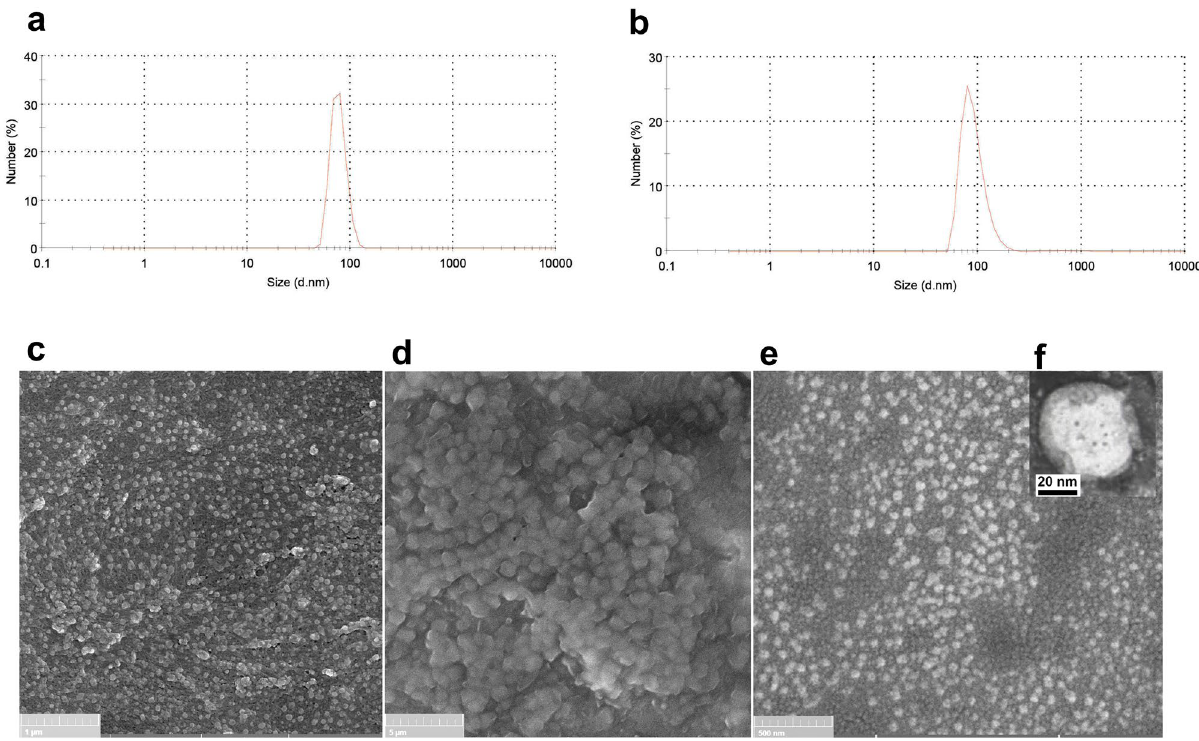
Figure 3. ( a ) DLS graphs of chitosan nanoparticles, ( b ) DLS graphs of chitosan-alginate nanoparticles, ( c ) FE-SEM image of chitosan nanoparticle, ( d ) SEM image of chitosan-alginate microparticles; ( e ) FE-SEM image of chitosan-alginate microparticles; and ( f ) TEM image of the chitosan-alginate 1419 cm −1 , and 1056 cm −1 , which corresponded to NH and OH stretching, stretching of the methyl group (– CH 3 ), C=O stretch of the amide group, aromatic C–H 2 bending, and C–O stretching, respectively. For TPP, the major peaks were detected at 1151 cm −1 , 905 cm −1 , and 710 cm −1 , corresponding to P=O stretch- ing, PO 3 group vibration, and P–O–P bridge asymmetric stretching, respectively. FTIR spectrum of chitosan particle corresponded to TPP and chitosan spectra, but the absorption bands slightly shifted. The infrared peaks of alginate were observed at 3440 cm −1 , 2926 cm −1 , 1620 cm −1 , 1383 cm −1 , and 1013 cm −1 , which ascribed to the OH stretch of the amide group, –CH 2 stretching, C=O stretch of the amide group, the asymmetric stretch of C–O–O, and C–O stretching, respectively. In the core–shell structure, peaks slightly shift from 1616 cm −1 and 1419 cm −1 to 1631 cm −1 and 1381 cm −1 , respectively. After the complexation of alginate with chitosan, the infrared peak of 2920 cm −1 was absent in this compound; the observed changes in the absorption bands of the amino groups, carboxyl groups, and amide bonds can be attributed to an ionic interaction between the carbonyl group of alginate and the amino group of chitosan. The peaks appeared at 3428 cm −1 , 2920 cm −1 , and 1631 cm −1 , attributed to the stretch of OH, CH, and C=O groups in chitosan and alginate components of the core–shell particle. The major peaks of BSA were observed at 3417 cm −1 , 2149 cm −1 , and 1633 cm −1 , corresponding to the stretch of OH/NH, CO 2 , and C=O groups. The FTIR peaks of BSA-loaded core–shell particles were overlapped with absorption bands of BSA and core–shell particle spectra, in a slightly shifting manner. Differential scanning calorimetric (DSC) analysis. Thermograms of DSC results are shown in Fig. 2b. Two endothermic peaks were appeared for BSA at 99 °C and 210 °C. The endothermic and exothermic peaks of 75 °C and 220 °C were appeared for chitosan while the same peaks of 95 °C and 313 °C were observed for alginate thermogram, respectively. Nevertheless, three different endothermic peaks of 74 °C, 183 °C and 227 °C and broader exothermic peak of 340 °C were detected for core–shell microparticles, which can be attributed to the chitosan-alginate complex, calcium chloride, BSA and polymer decomposition, respectively. Dynamic light scattering (DLS) and zeta potential analysis. Figure 3a,b shows the particle size and its distribution results, which were measured using DLS. For the chitosan and chitosan-alginate nanoparticles, the size and PDI of 76.73 nm, and 0.3 and 90.49 nm, and 0.35 were obtained, respectively. In addition, their zeta potential was 43.6 ± 5.08 mV and − 6.35 ± 2.23 mV, respectively.